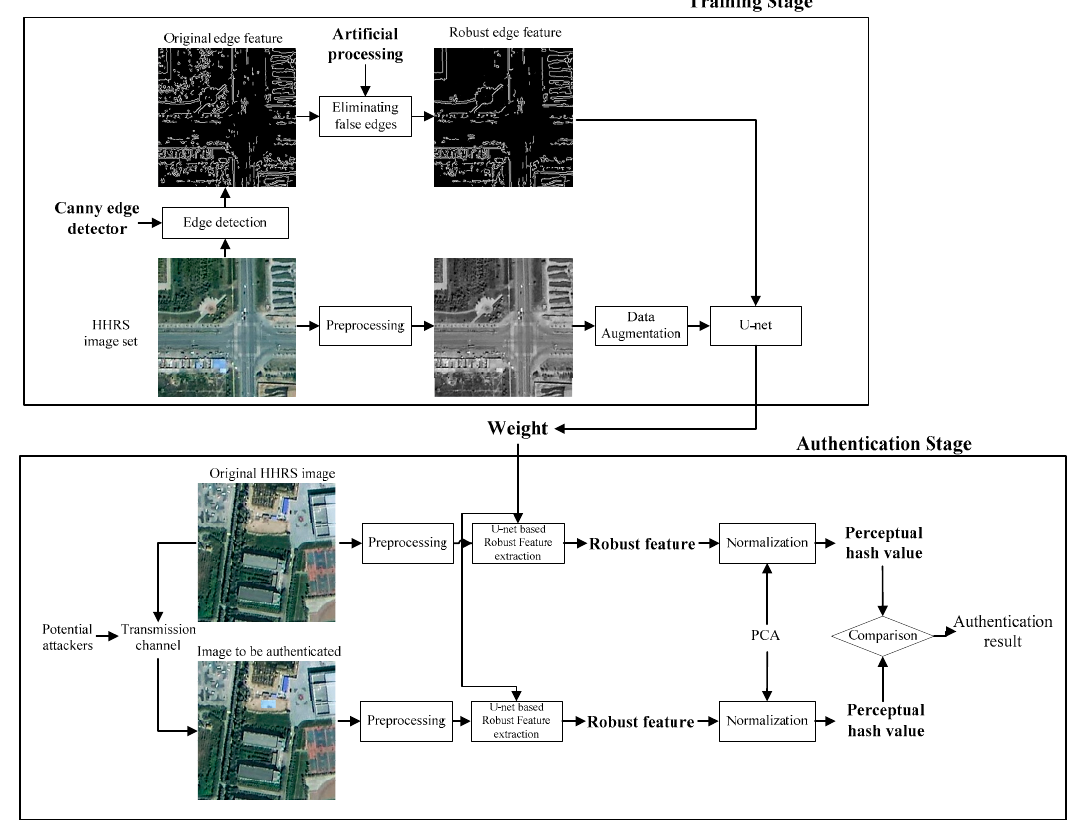
Figure 2. Framework of the proposed scheme.